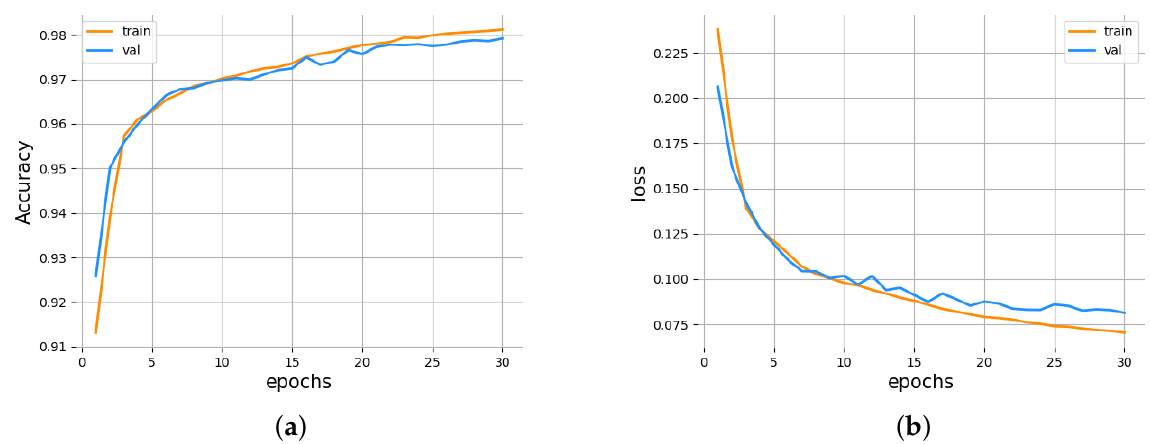
Figure 11. Accuracy curve and loss curve of the experimental model.